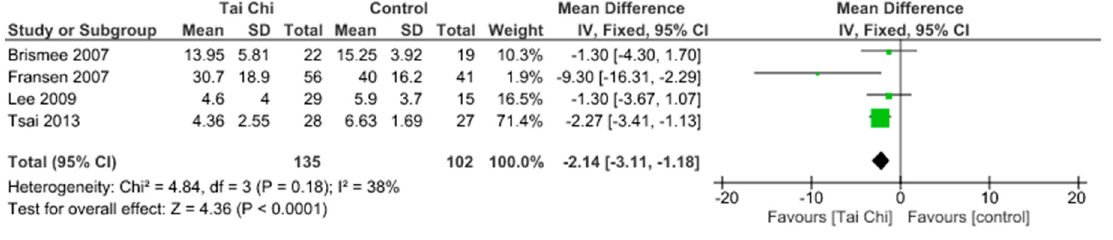
Figure 5. Pain: Tai Chi versus Control.